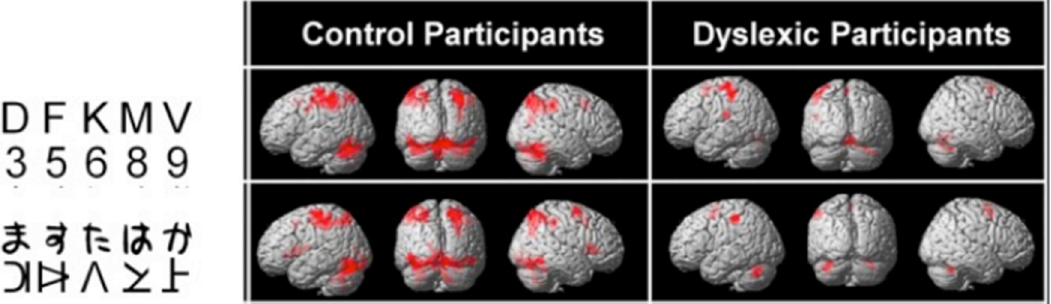
Figure 5. Brain activation by alphanumeric ( top ) and nonalphanumeric ( below ) strings in controls and dyslexics. Underactivation of the superior parietal lobules (mainly right ) in dyslexics [45]